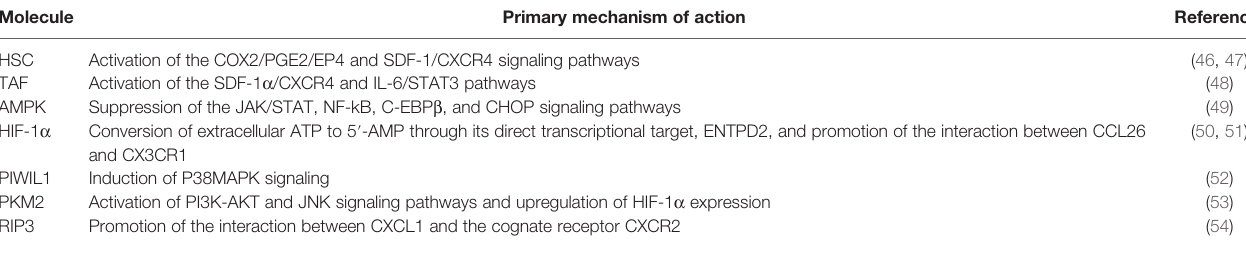
TABLE 1 | Other factors stimulate MDSC accumulation in hepatocellular carcinoma.